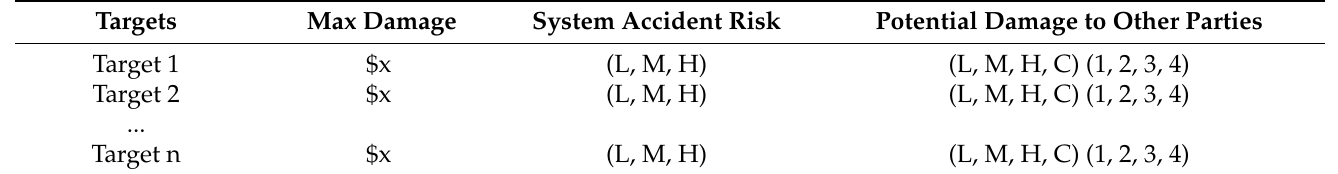
Table 2. Reference table for system risk factors for each target of AI